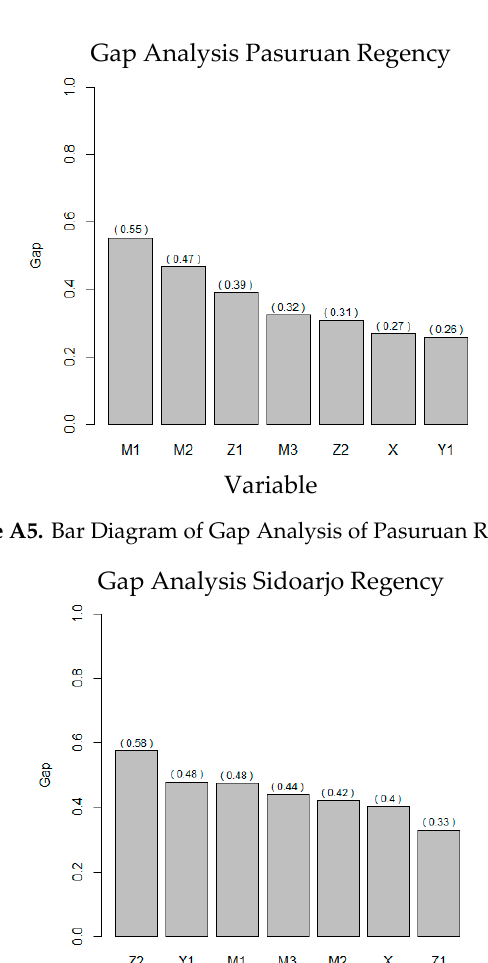
Figure A4. Bar Diagram of Gap Analysis of Pasuruan City.